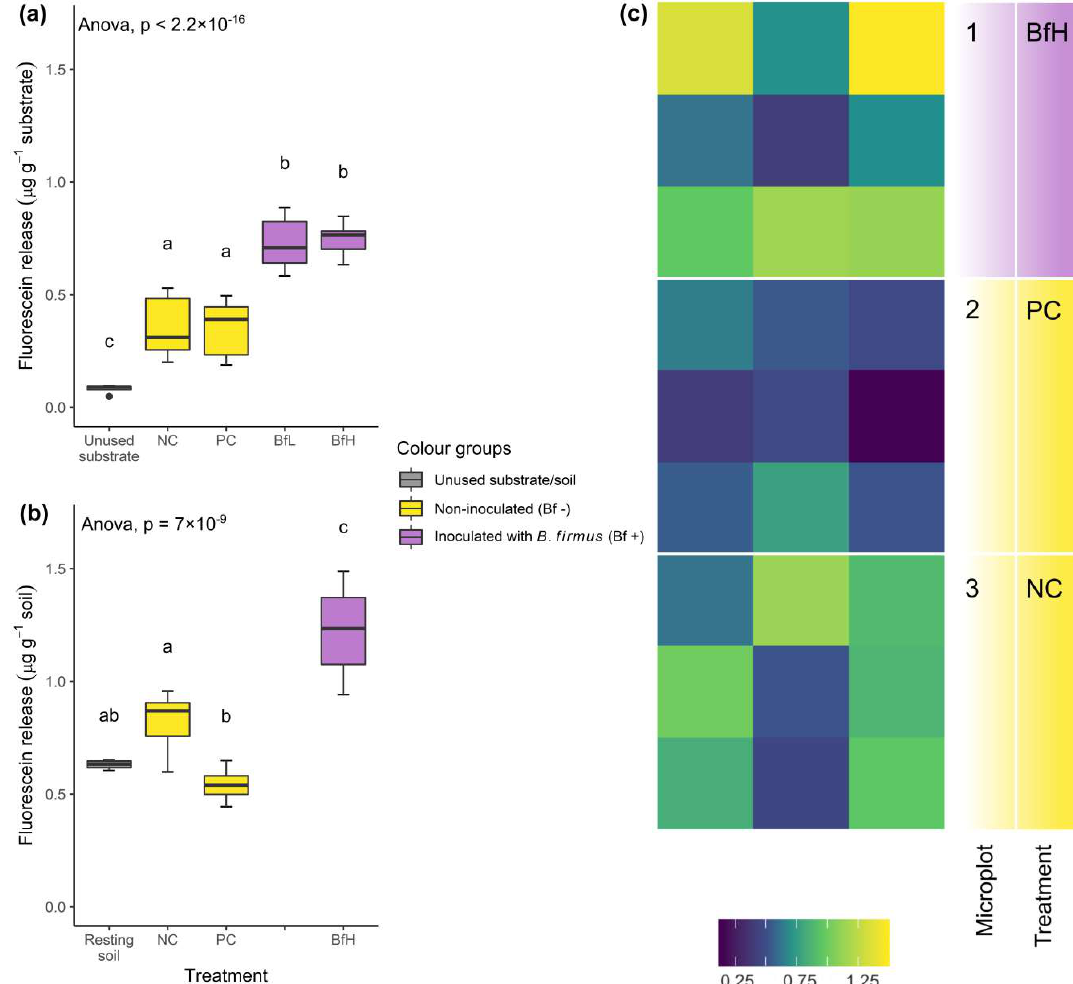
Figure 2. Microbial activity measurements of the substrate and soil from ( a ) pot experiments and ( b ) microplot experiments with di ff erent treatments. Data from the pot (n = 16) and microplot experiments (n = 12) are presented with a box-plot showing the results of ANOVA and Tukey’s HSD test. Treatments sharing a letter were not significantly di ff erent at p < 0.05 and are coloured according to the presence or absence of Bacillus firmus inoculum. ( c ) Spatially resolved total microbial activity in the microplot soil, as measured by fluorescein release ( µ g g − 1 ), ranging from lower (violet-blue) to higher (yellow) enzymatic activity, presented in an area heatmap. NC—negative control; PC—positive control